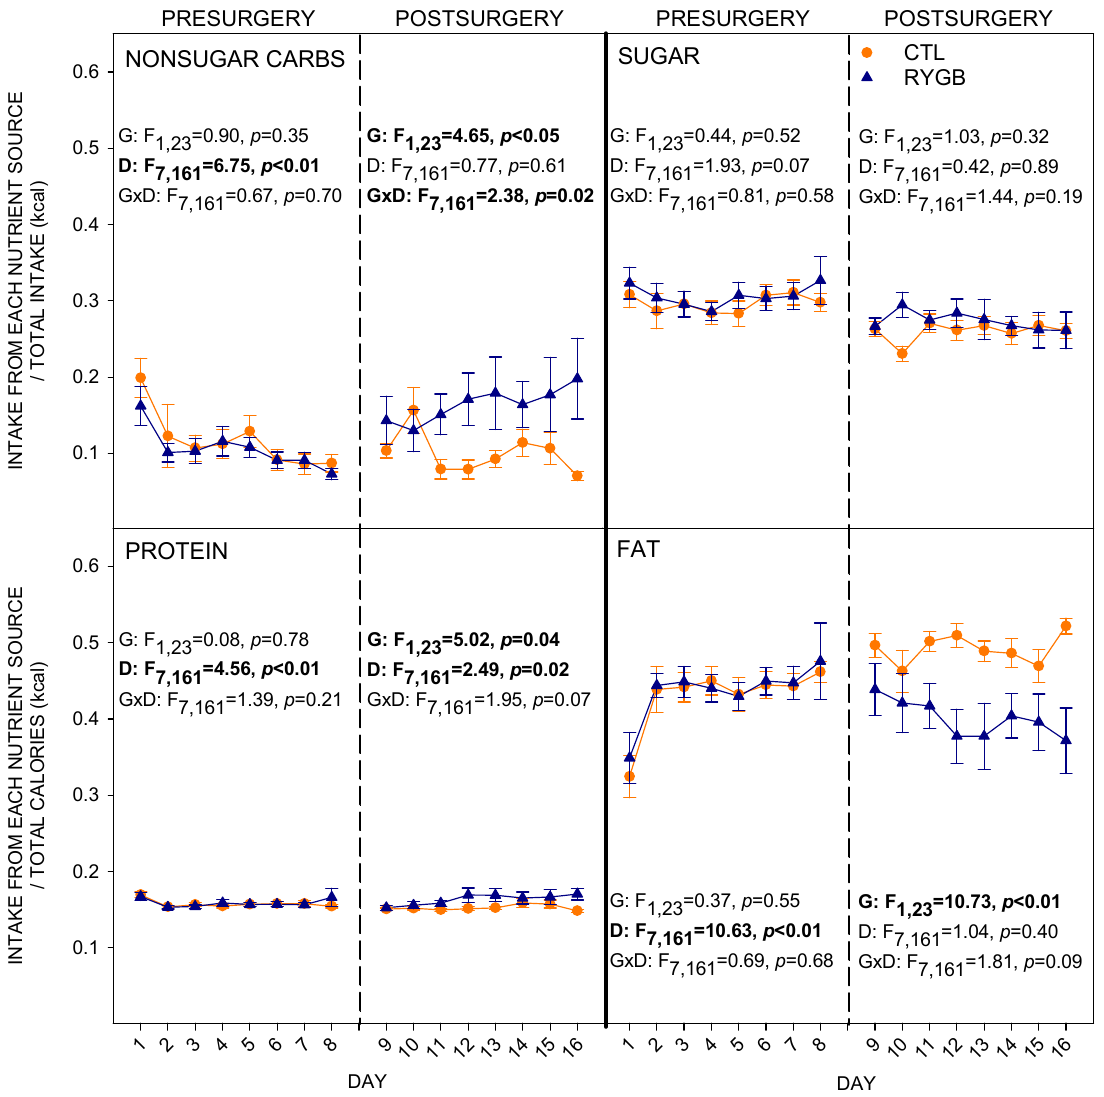
Figure 5. Daily Proportion of Energy from Each Primary Nutrient Source. Mean ( ± SE) proportion of energy (in kcal) across both pre-surgical and post-surgical days are presented for CTL (combined SHAM and IRON groups, n = 14; orange circles) and RYGB ( n = 11; blue triangles). Inset: results from two-way mixed ANOVAs (G: group, D: day, G × D: group × day), with significant results in bold. Table 4. Two-way ANOVAs Comparing 22-H Meal Sizes between Groups for Each Diet Condition.